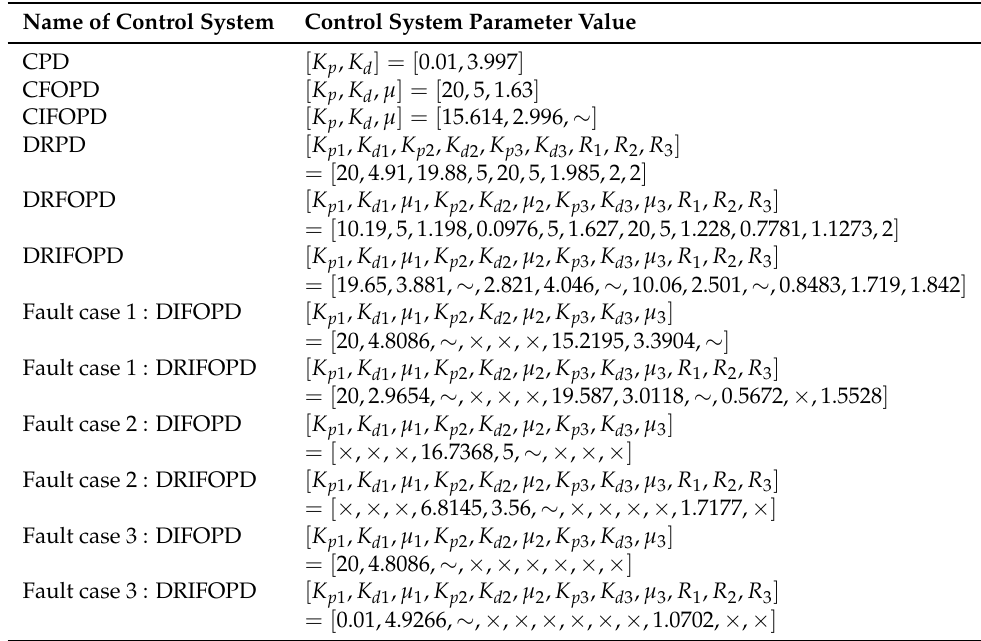
Table A3. Control system